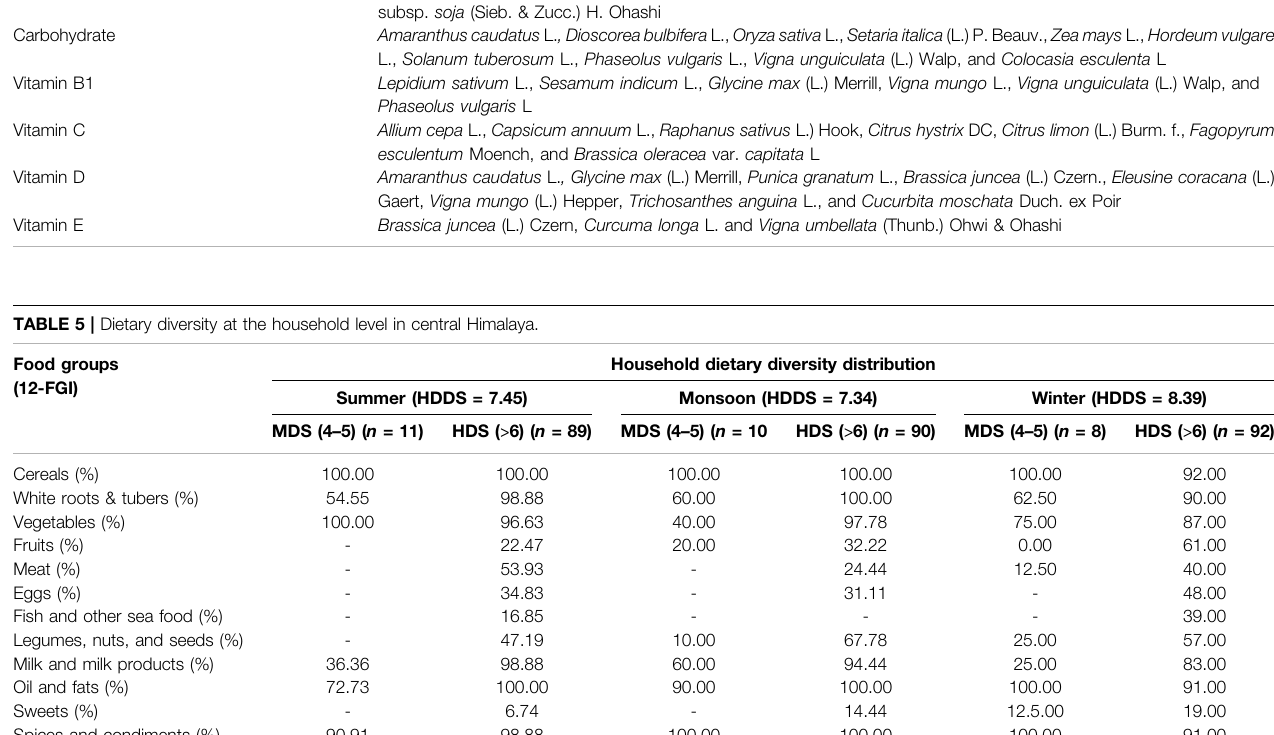
TABLE 4 | Key nutrient-rich food crops used in traditional diets. Use purpose Key sources in traditional diet (crop species)